Question: In a single sentence, describe what this figure presents.
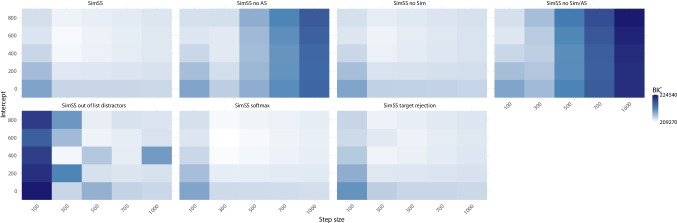
Answer: Shown are the BIC values of the fitted models across various stepsizes and intercepts. We used this coarse grid search to determine the best stepsize and intercept for each model